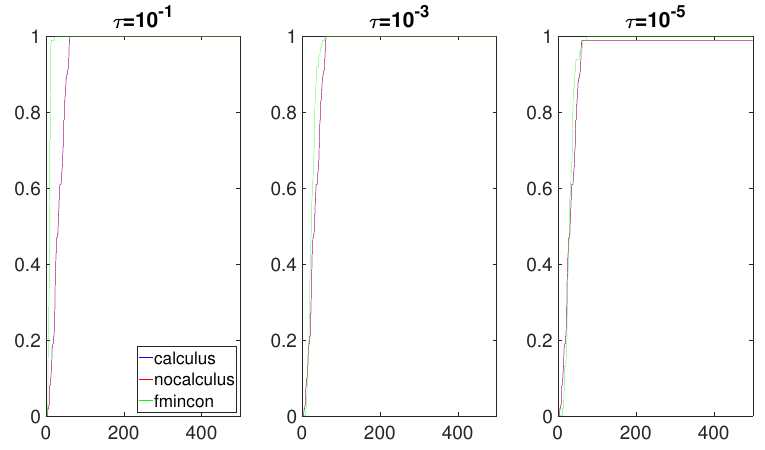
Figure 6. Data profiles when F = f 1